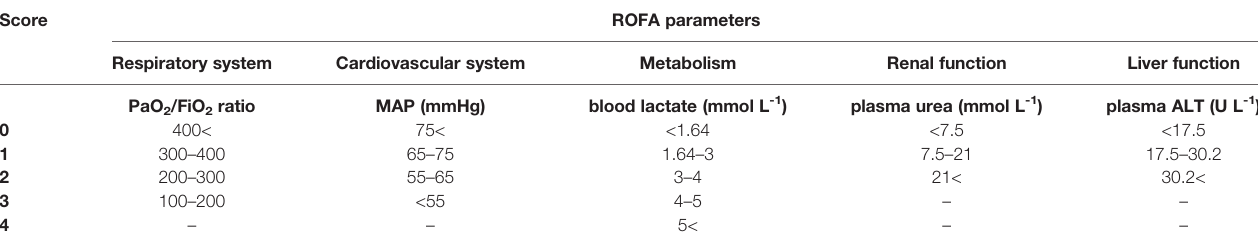
TABLE 1 | Threshold values of the components of the rat-speci fi c organ failure assessment (ROFA) scoring system. Sepsis was de fi ned as cumulative ROFA score above 2. Score ROFA